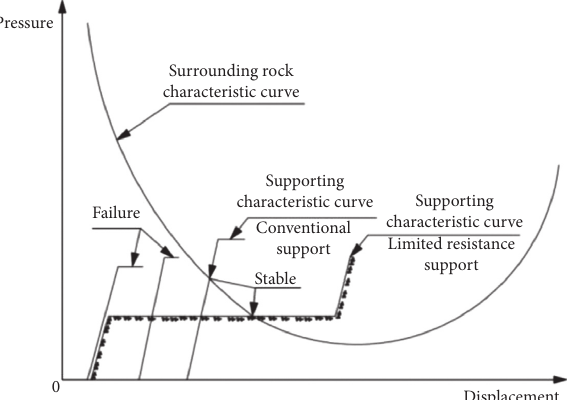
Figure 1: Characteristic curve of